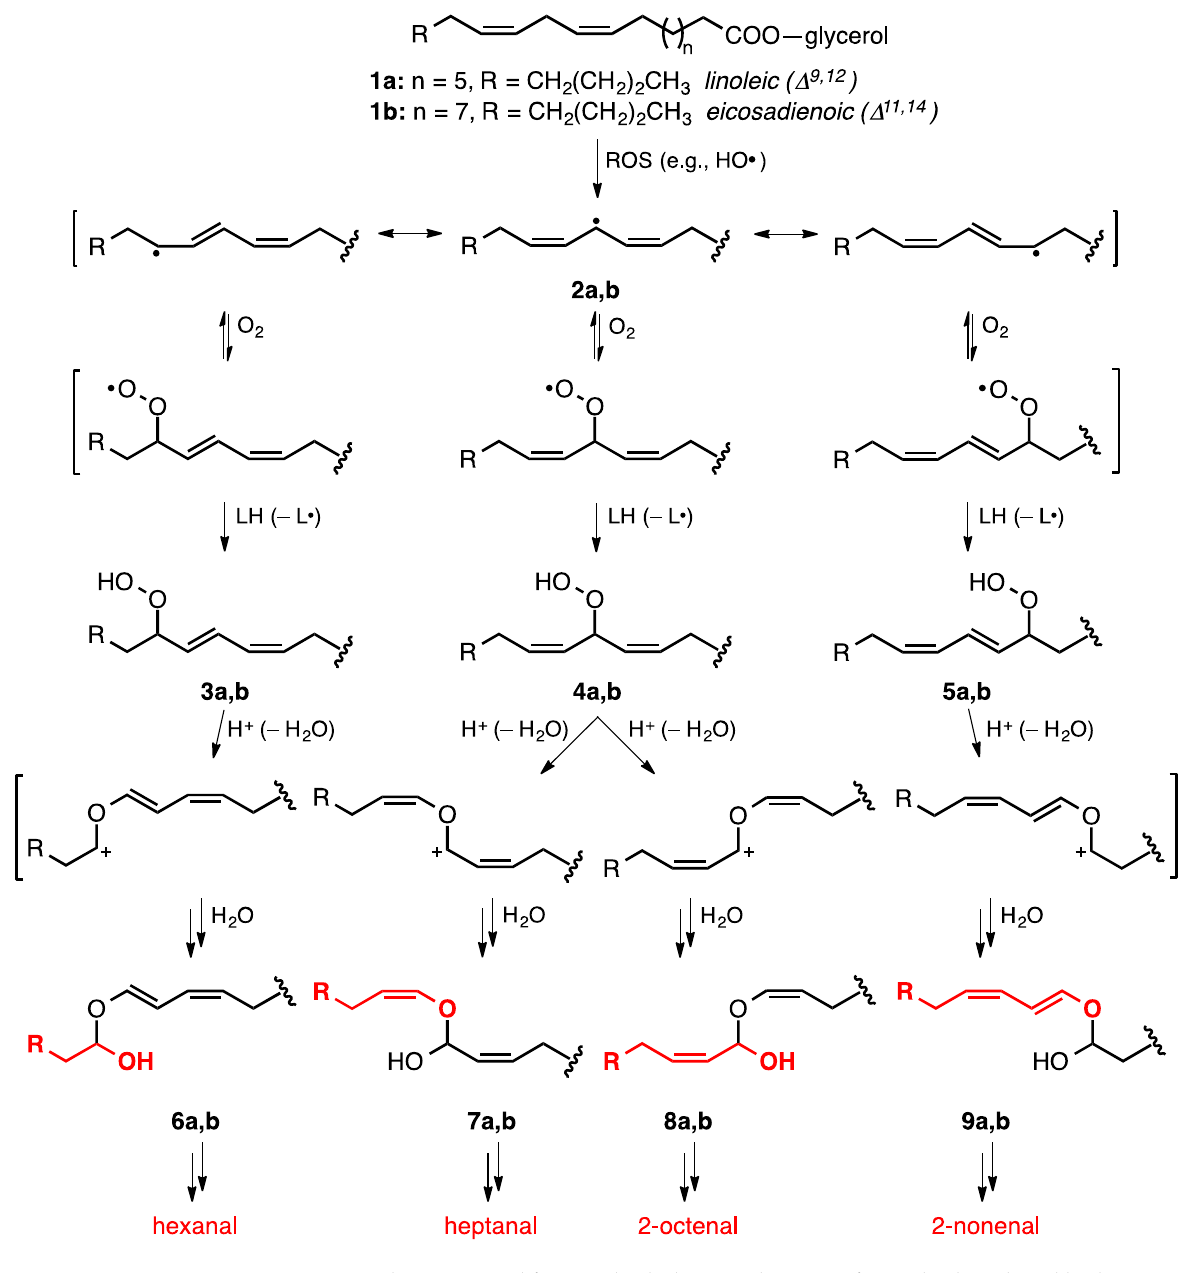
Figure 2. Polyunsaturated fatty acyl sidechain oxidation via free radical-mediated hydro-peroxide formation and decomposition leads to mixtures of saturated and unsaturated aldehydes (ROS = reactive oxygen species; LH = neighboring lipid). Atoms in red give rise to the aldehydes generated on hemiacetal equilibrium.